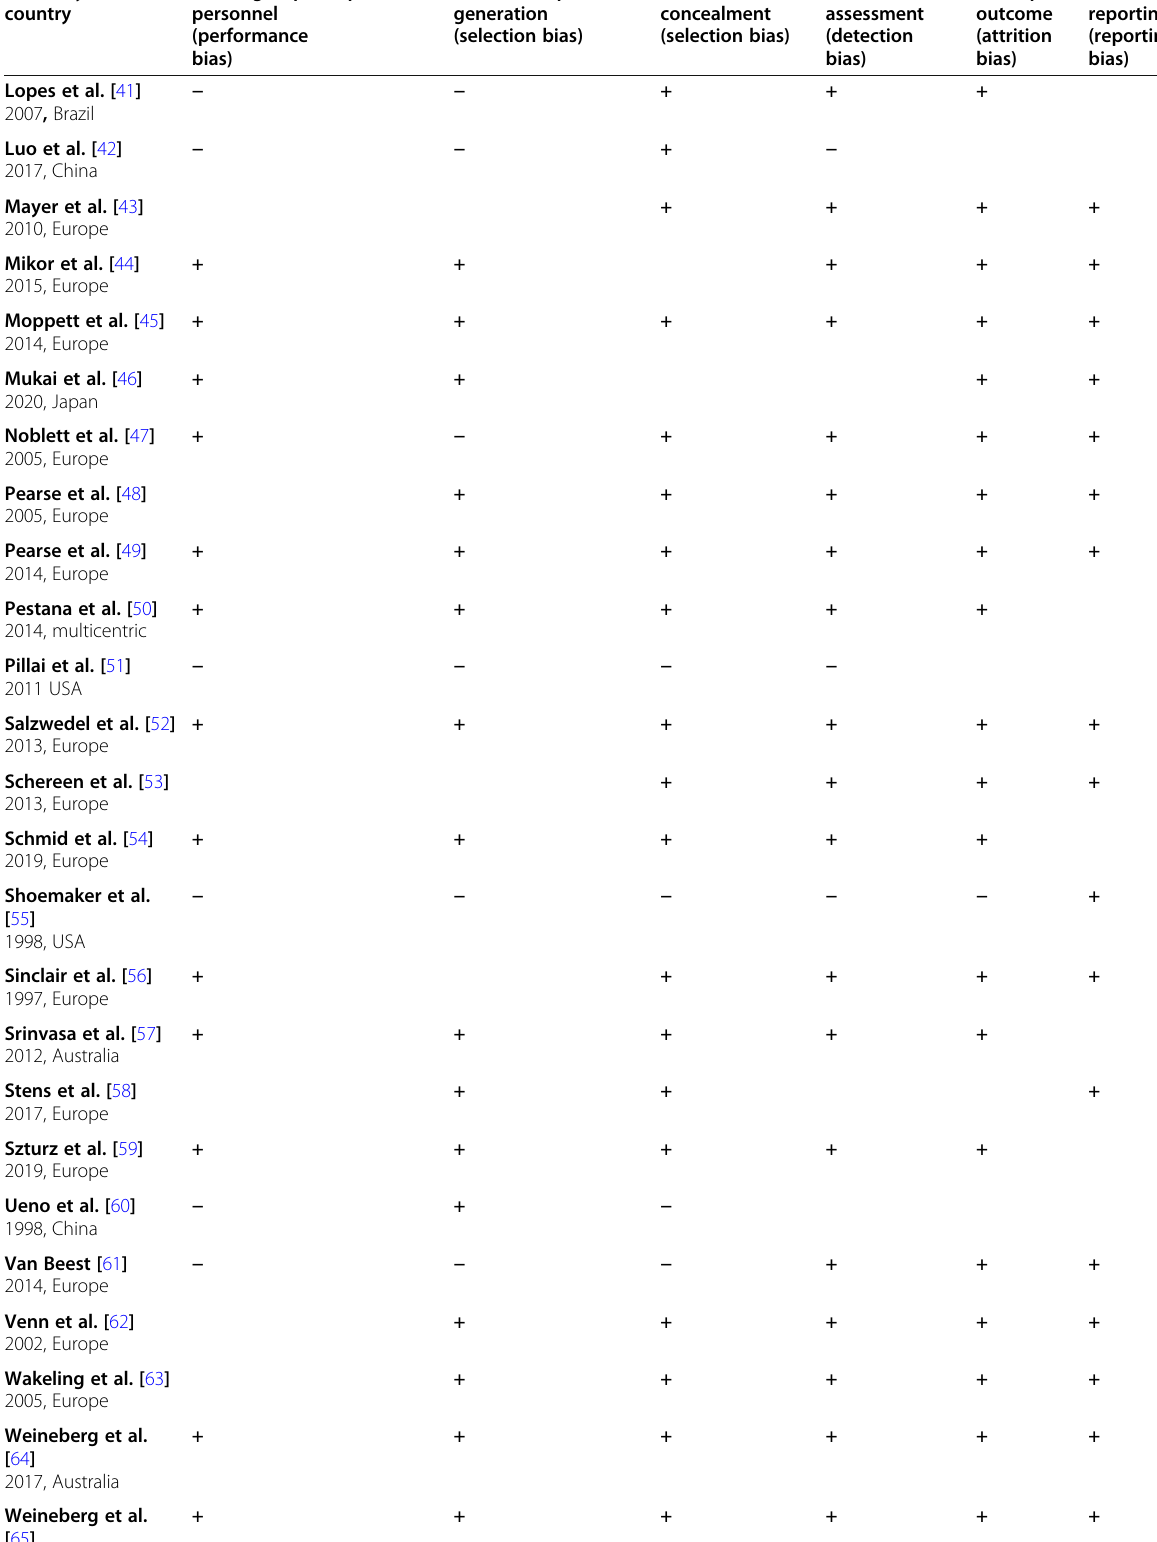
Table 2 The risk of bias assessment for each trial, according to the Cochrane domain-based evaluation (Continued) Author, year,